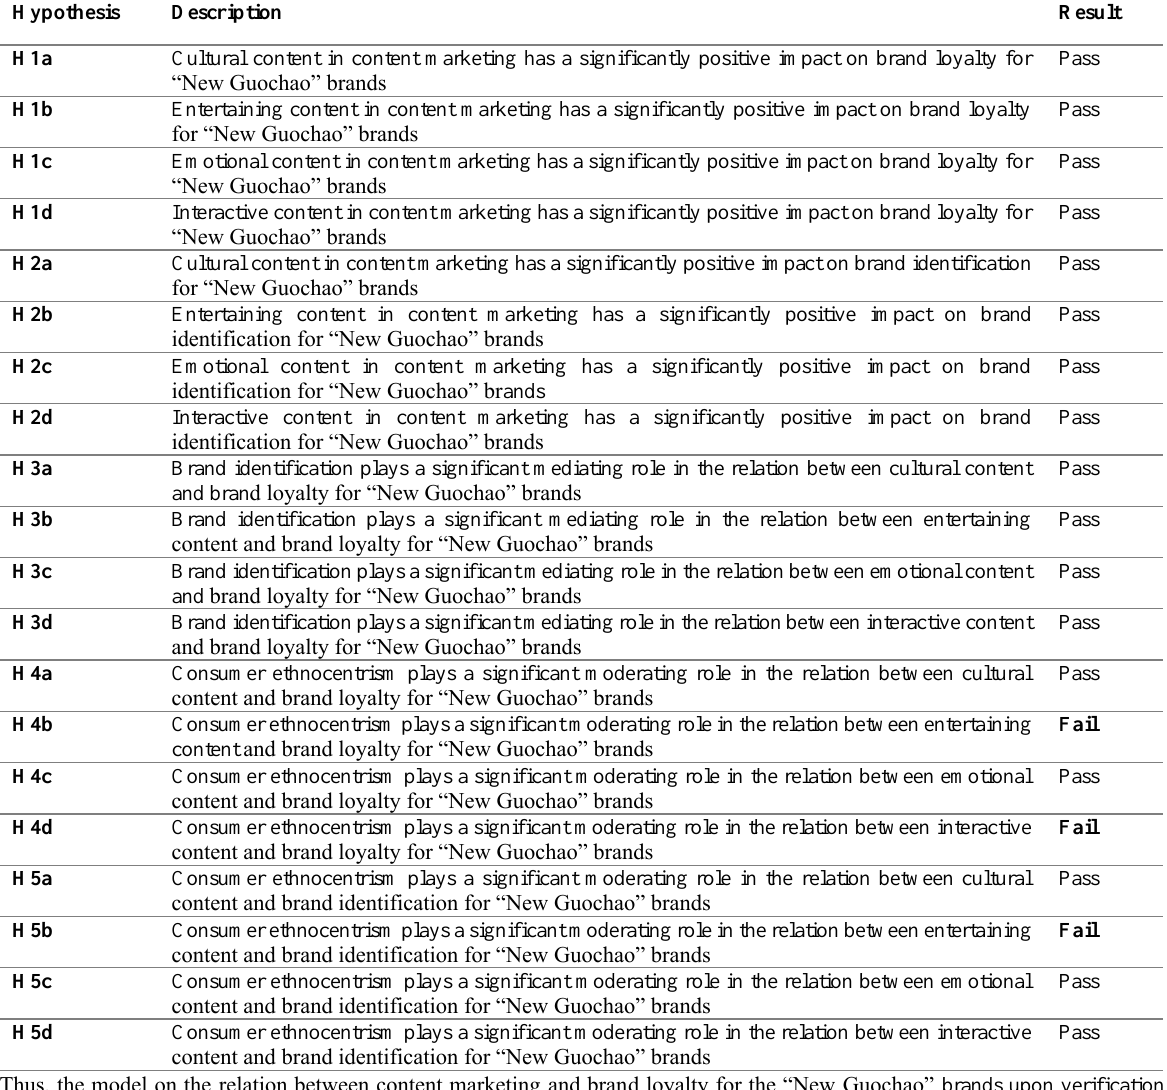
Table 8: Summary of final results of model